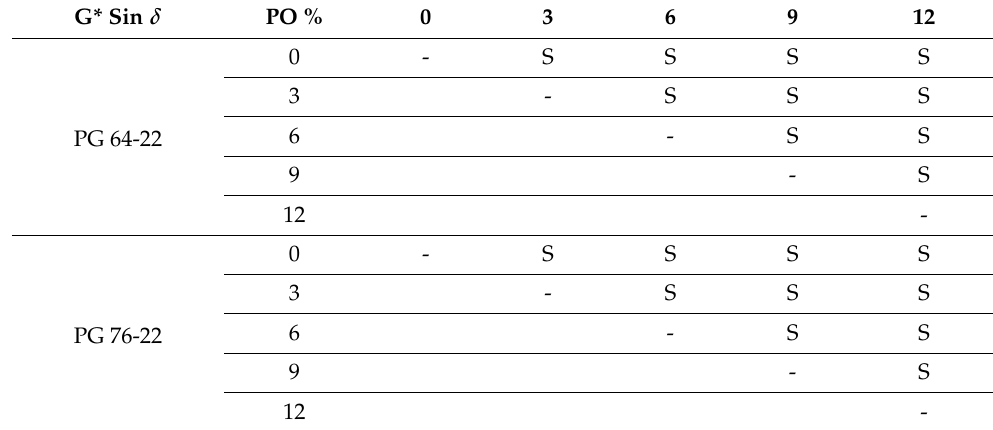
Table 7. Statistical analysis results of the G*sin δ as a function of processed oil content ( α = 0.05). G* Sin